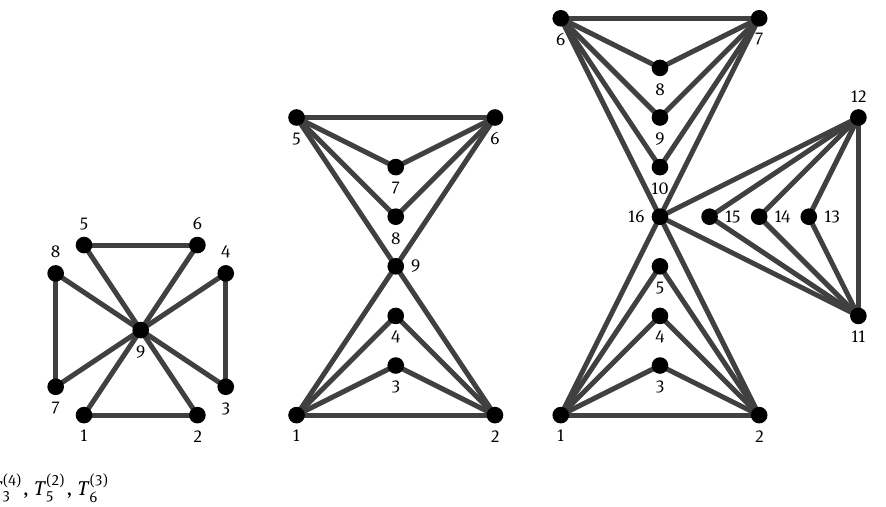
Figure 2: T (4) 3 , T (2) 5 , T (3)